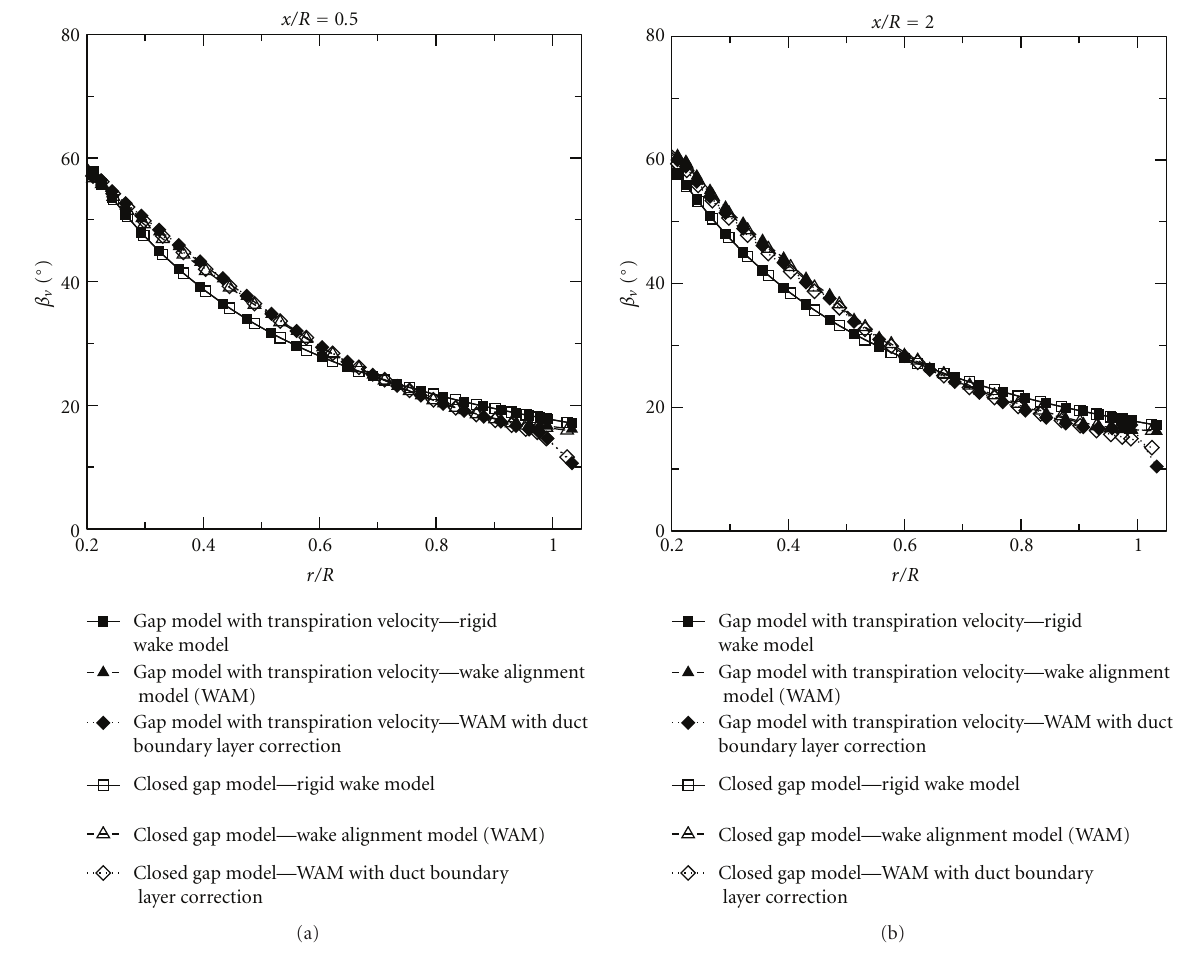
Figure 10: Vortex pitch distributions at x/R = 0 . 5 and x/R = 2 . 0. Influence of gap and wake models. Ka4-70 inside duct 19Am at J = 0 . 5.